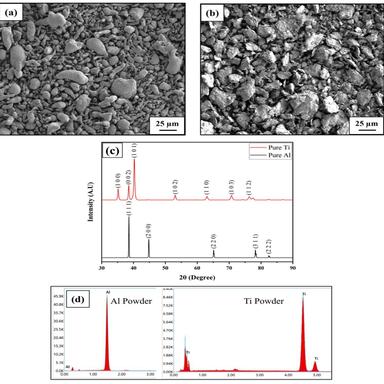
(a) SEM image of pure Al and (b) pure Ti, (c) XRD of pure Al and Ti powder (d) EDS spectra of Al and Ti powder.